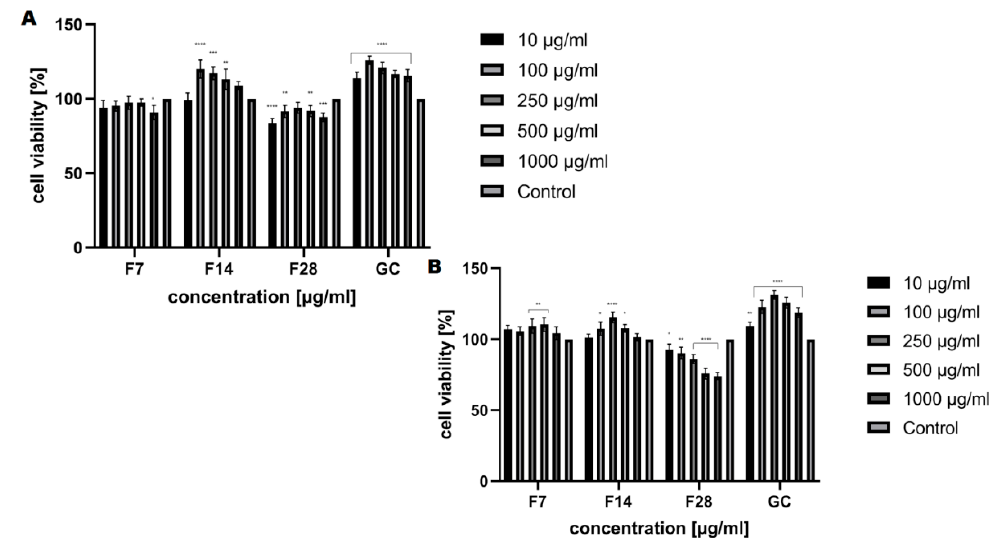
Figure 8. The reduction of resazurin after 24 h exposure to the ferments obtained from green coffee beans (1–1000 µg/mL) in cultured ( A ) fibroblasts (BJ) and ( B ) keratinocytes (HaCaT). Data are the mean ± SD of three independent experiments, each of which consists of three replicates per treatment group. For BJ, **** p < 0.0001, *** p < 0.0007 versus the control (100%). For HaCaT, **** p < 0.0001 *** p < 0.0008, ** p < 0.003, * p < 0.04 versus the control (100%).